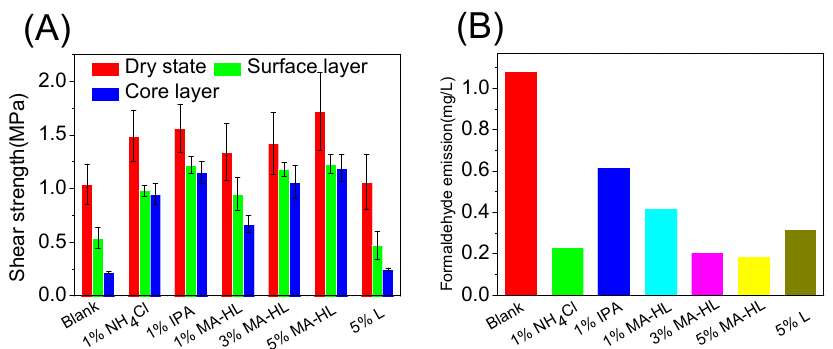
Figure 6. Properties of five-layer plywood prepared with UF resins containing different curing agents: ( A ) Shear strength and ( B ) Formaldehyde emission.